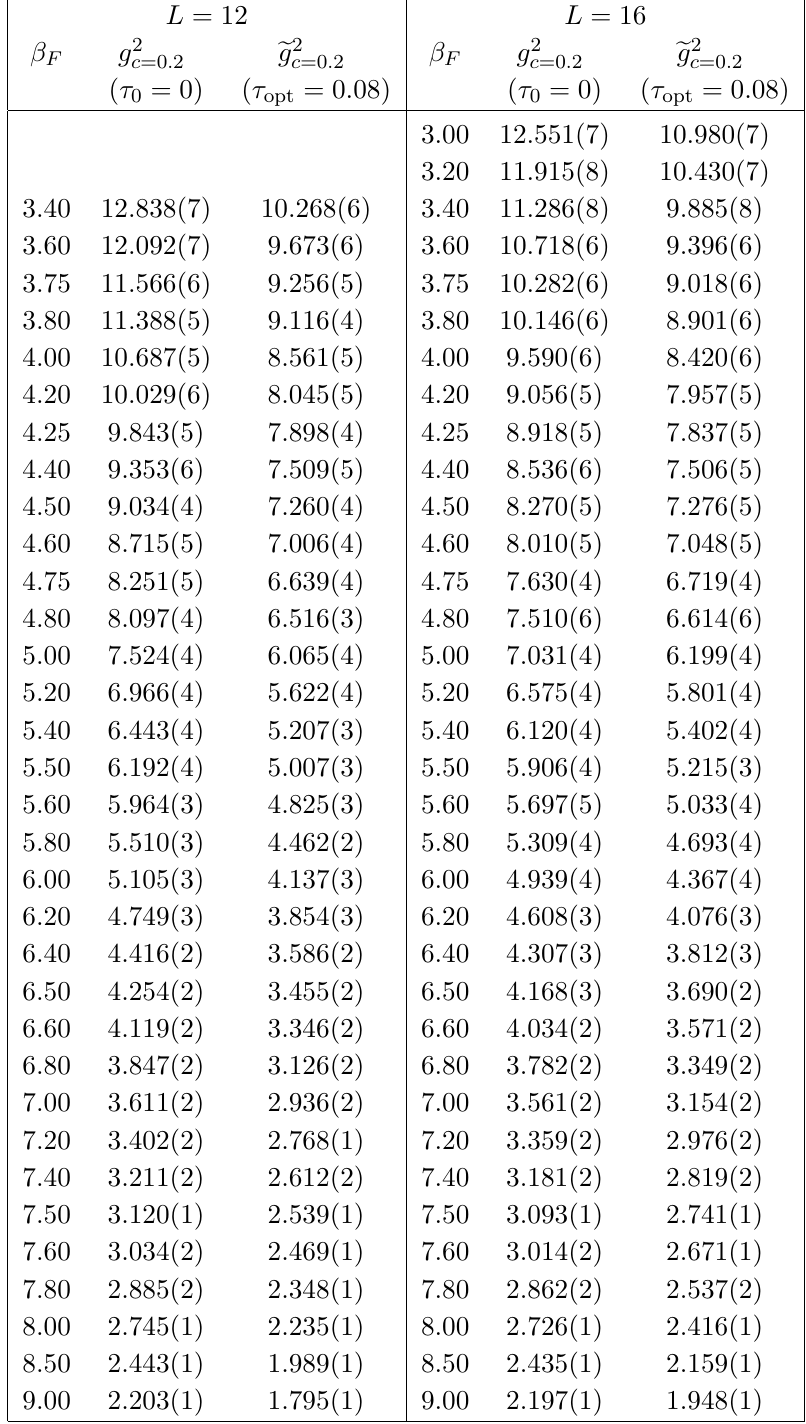
Table 11 . Renormalized gradient (cid:13)ow couplings in the c = 0 : 2 scheme for the 12 4 and 16 4 lattice ensembles used in this work, for the clover discretization of E ( t ) with both (cid:28) 0 = 0 and the optimal (cid:28) opt = 0 :